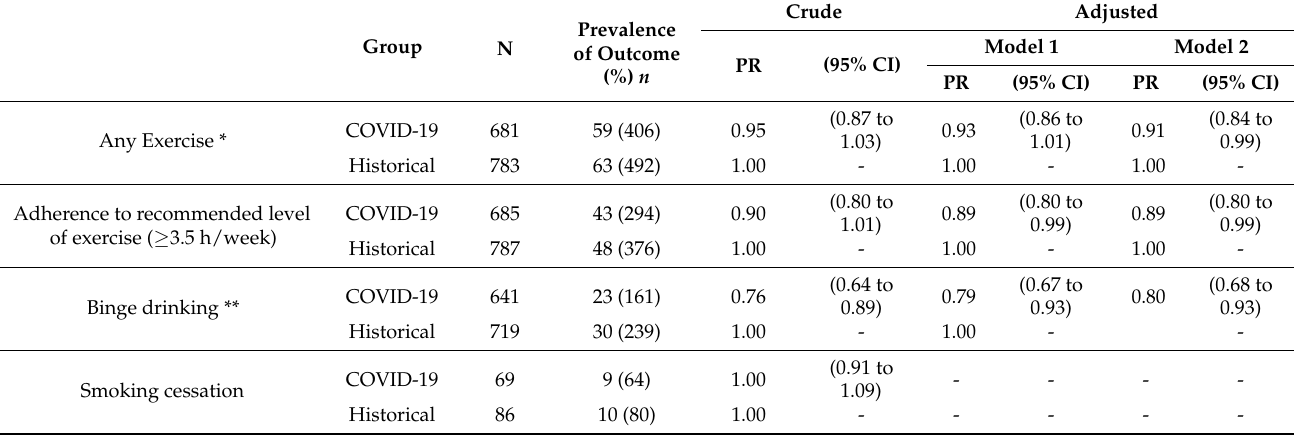
Table 2. Prevalence ratios (PRs) and associated 95% confidence intervals (CI) of exercise, binge drinking, and smoking cessation in the COVID-19 group compared with the Historical